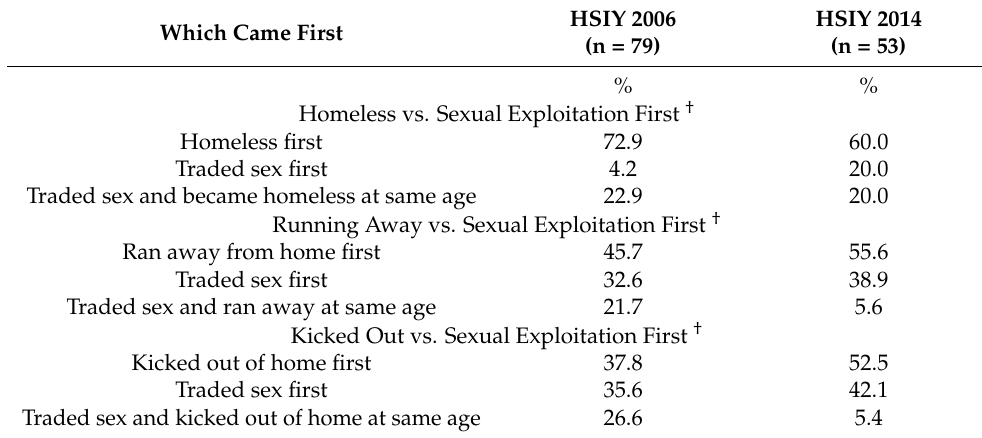
Table 4. Timing of sexual exploitation vs. running away or